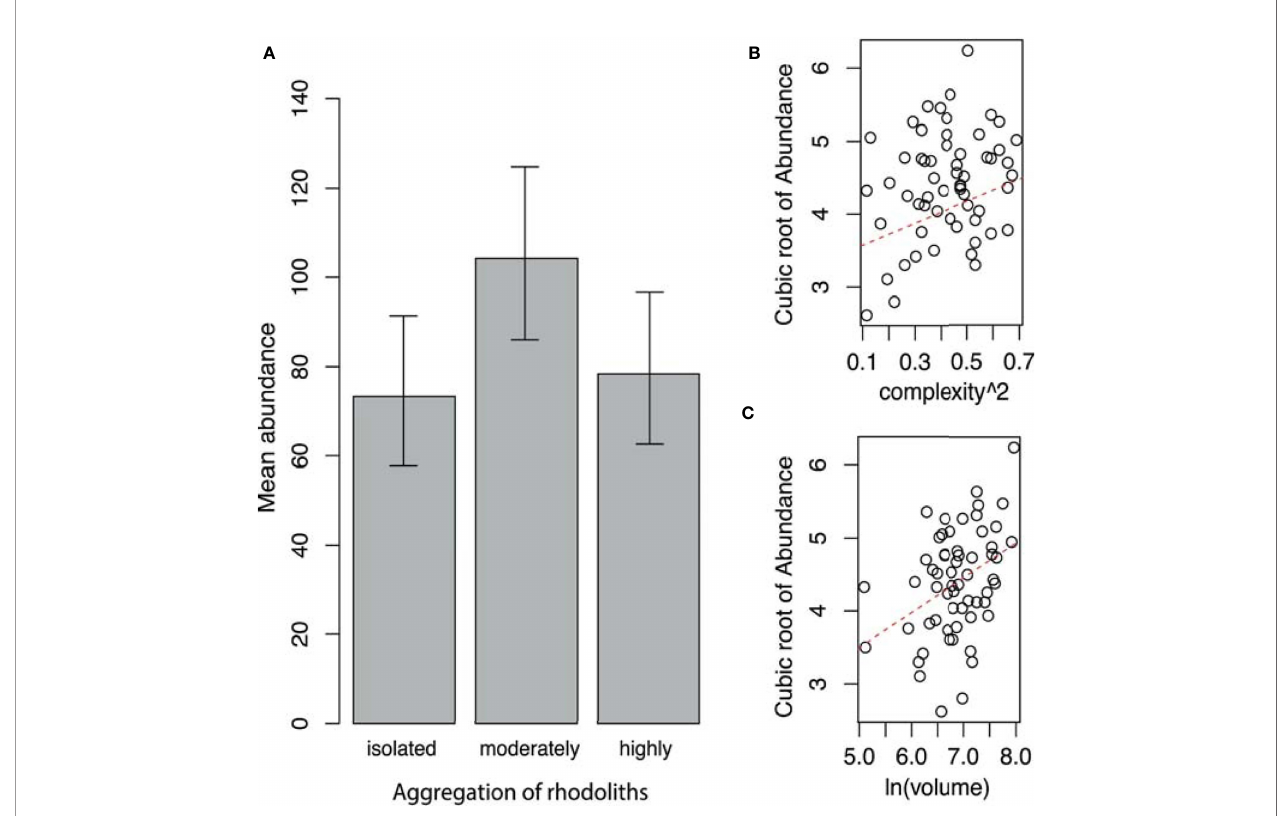
FIGURE 5 | (A) Mean abundance of fauna (with 95% con fi dence limits) by aggregation of rhodoliths. (B) Relationship between the abundance of fauna and complexity of rhodoliths. (C) Relationship between the abundance of fauna and volume of rhodoliths (Isla del Coco, Costa Rica).